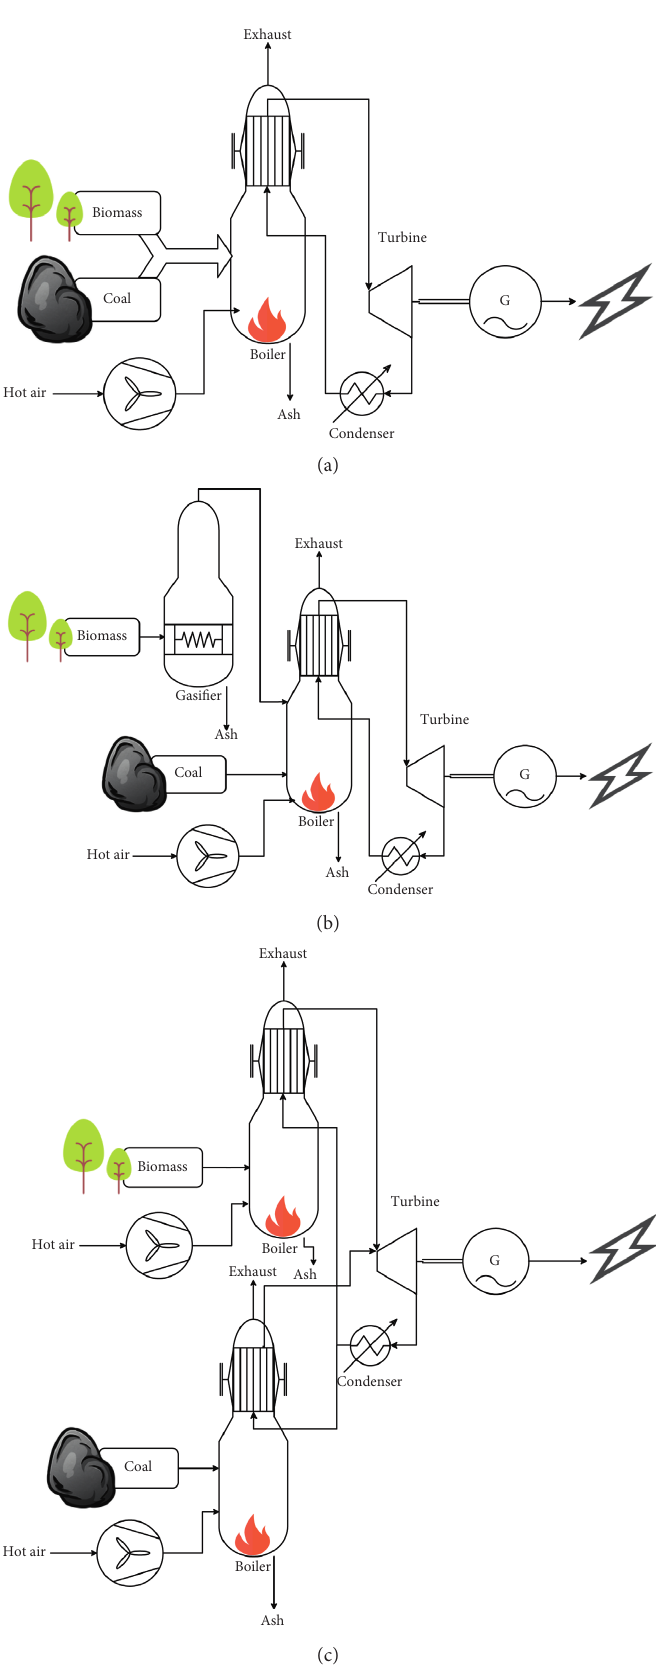
Figure 5: Cocombustion techniques: (a) direct cocombustion, (b) indirect cocombustion, and (c) parallel cocombustion